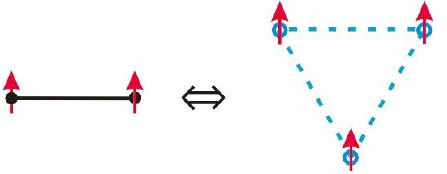
Figure 4. Mapping between a two-spin interaction for a link in a star lattice (i.e., the AMC model) and a three-spin interaction for a triangle in a triangular lattice. and a three-spin interaction for a triangle in a triangular